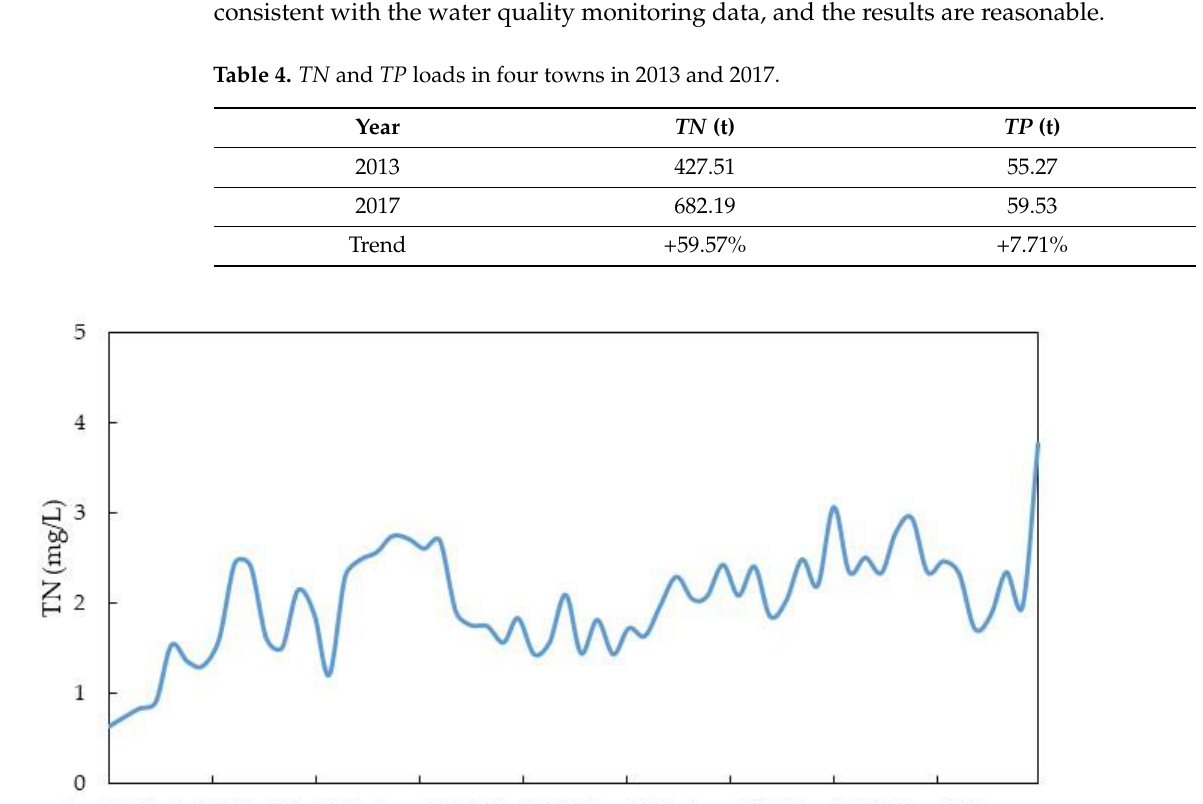
Figure 9. TP loads at the town scale in the Hongfenghu reservoir watershed.